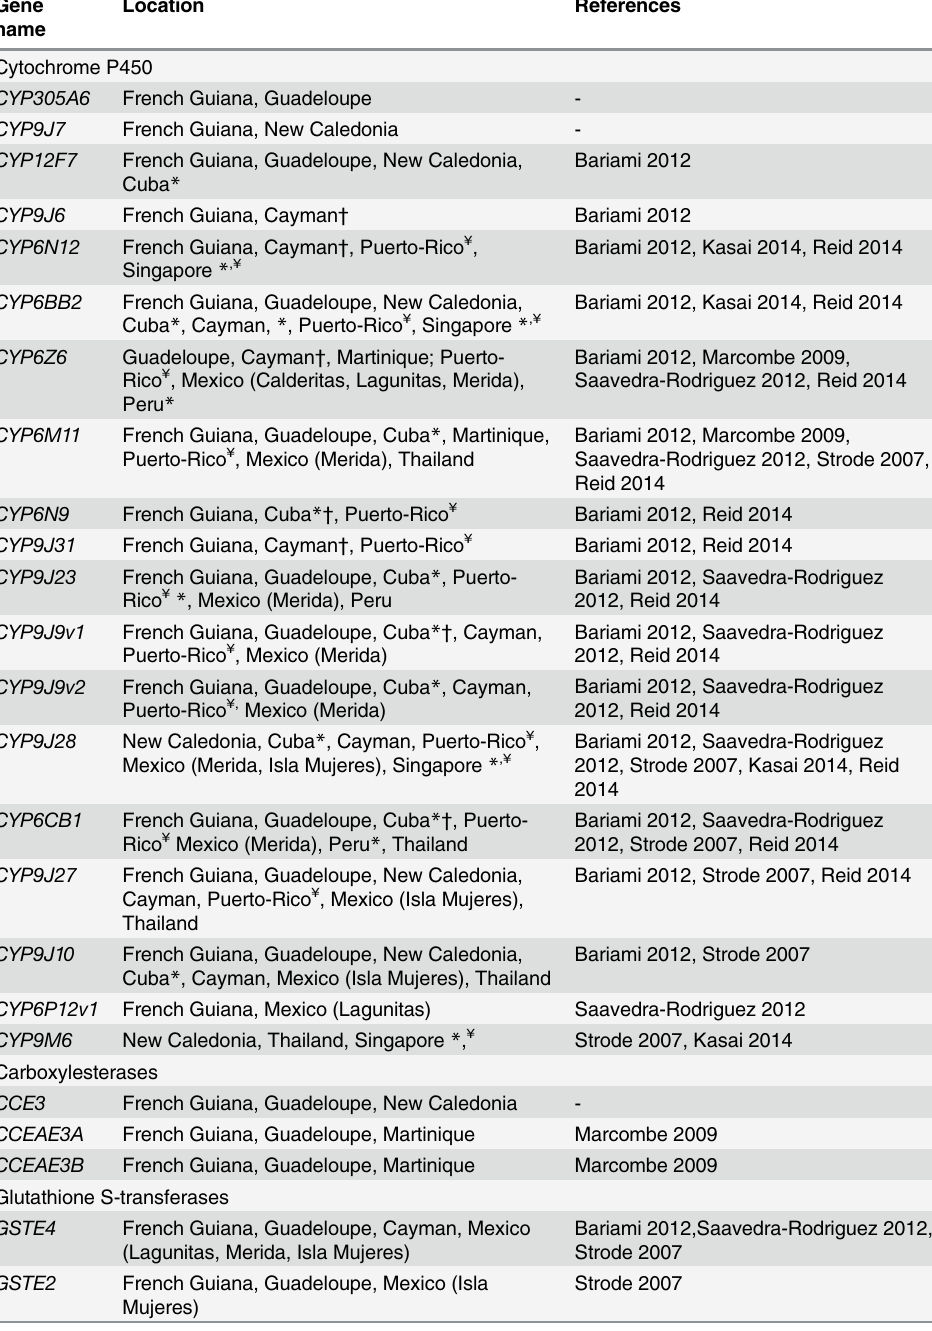
Table 2. Up-regulated genes found in our study and other pyrethroid resistance populations world- wide. The number and name of populations where they were up-regulated and references are